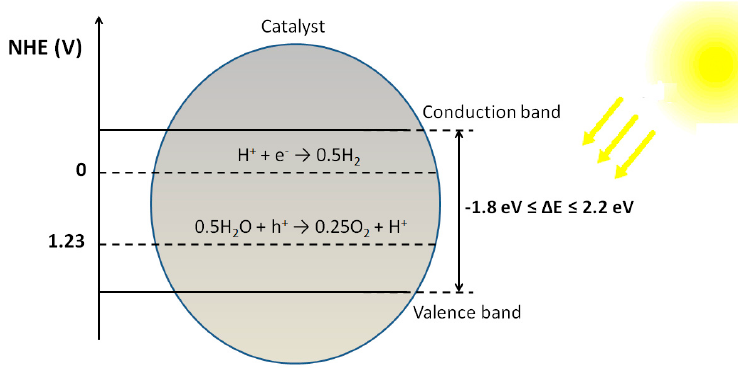
Figure 2. Band potentials and energy gap required for solar-driven photocatalytic water splitting.